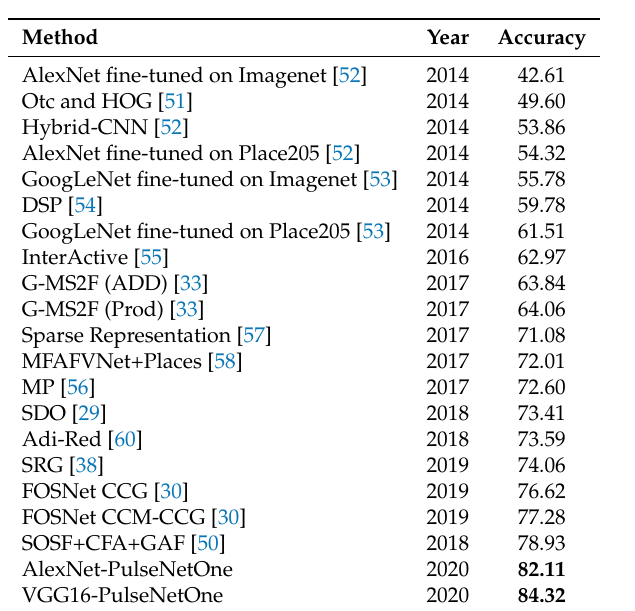
Table 11. A comparison between state-of-the-art and PulseNetOne results on the SUN397 dataset. The entries in bold show the method with the best classification for the network.